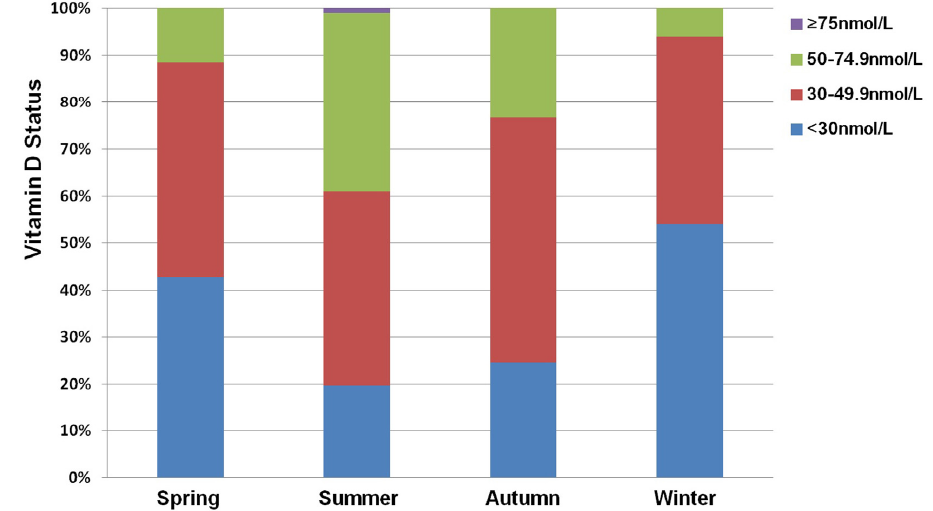
Figure 2. Vitamin D status among pregnant women based on different seasons for blood